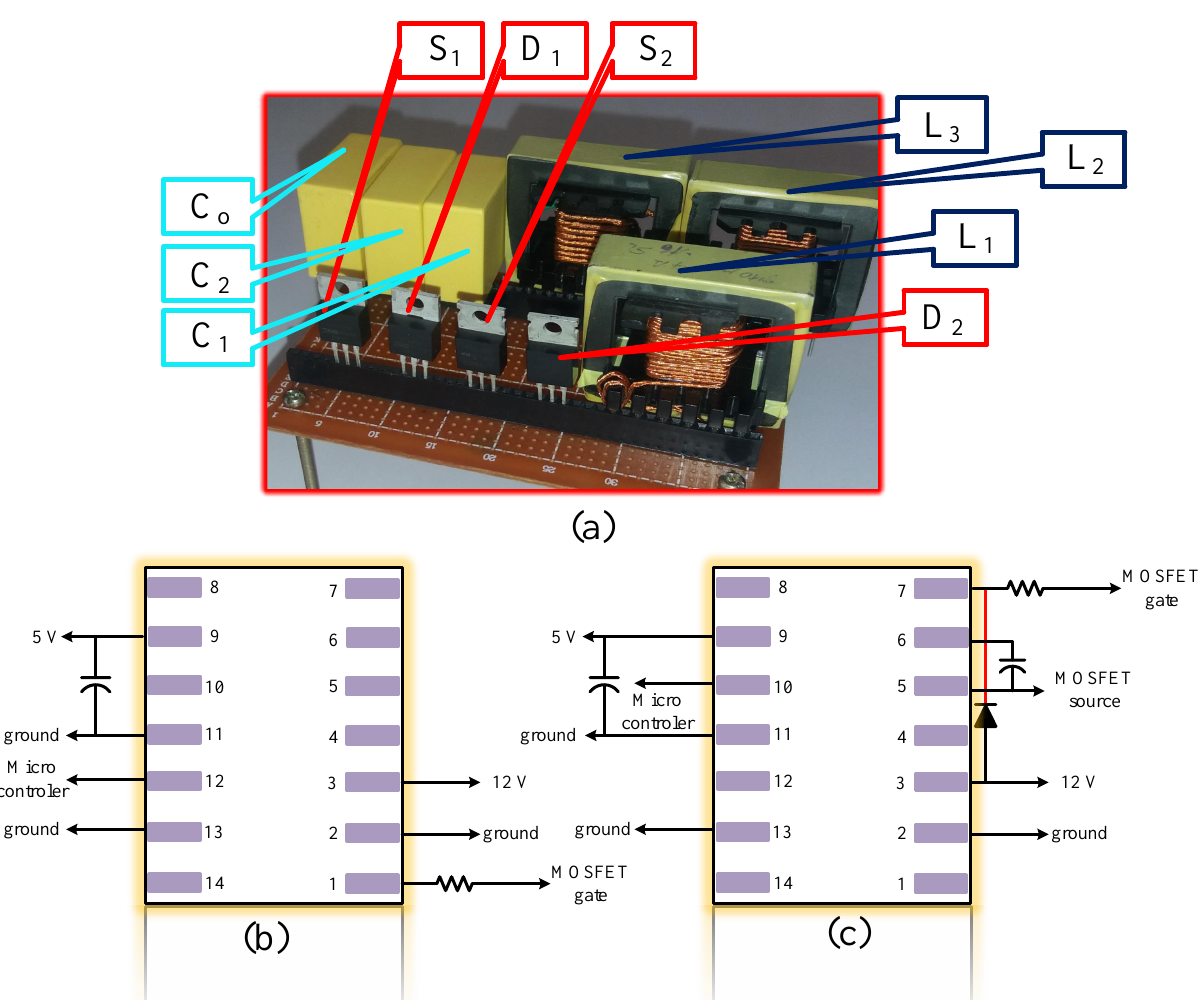
Figure 7. The experimental results: ( a ) inductors current; ( b ) capacitors voltage; ( c ) semiconductors current; ( d ) inductors voltage; ( e ) capacitors current; ( f ) semiconductors voltage.